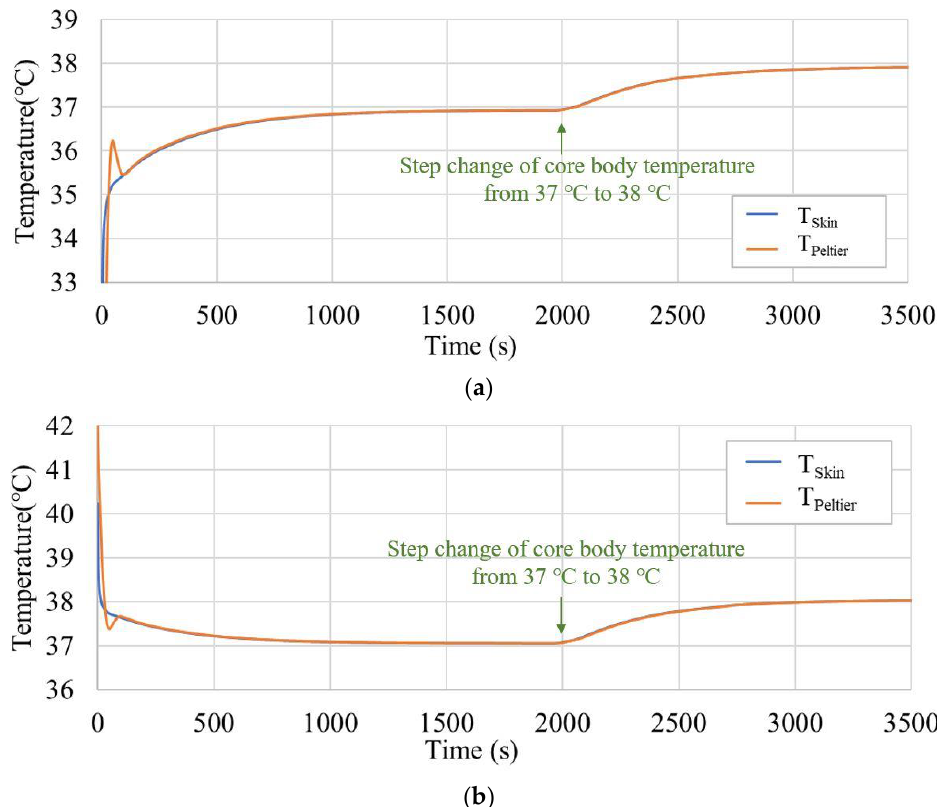
Figure 5. Thermistor temperature results from finite element analysis: ( a ) T Air = 25 °C and ( b ) T Air = 42 °C.